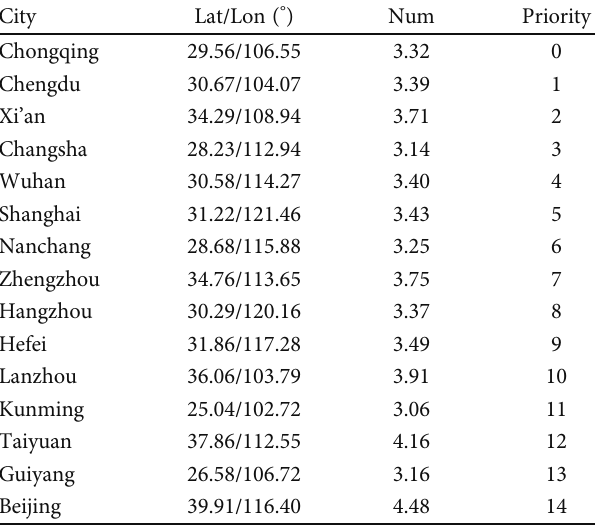
Table 3: The parameters of cities.